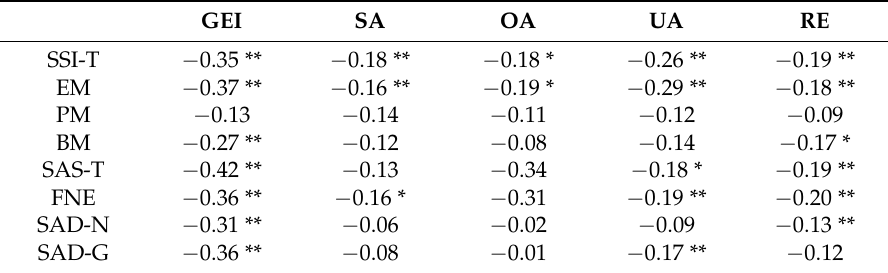
Table 3. Pearson correlations between variables under